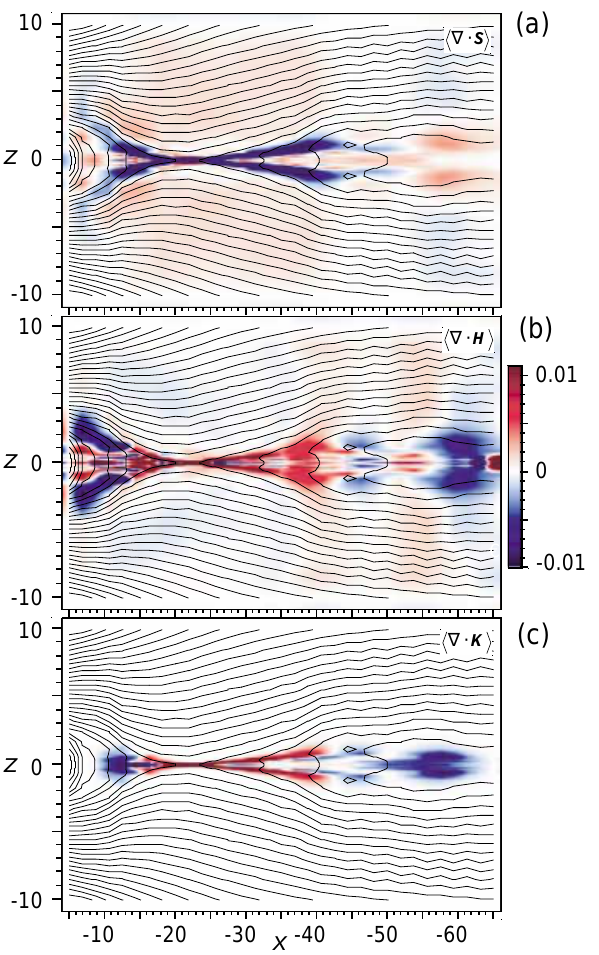
Fig. 4. Divergence of the energy fluxes, shown in Fig. 2, integrated over y : (a) Poynting flux, (b) enthalpy flux, (c) kinetic energy flux.